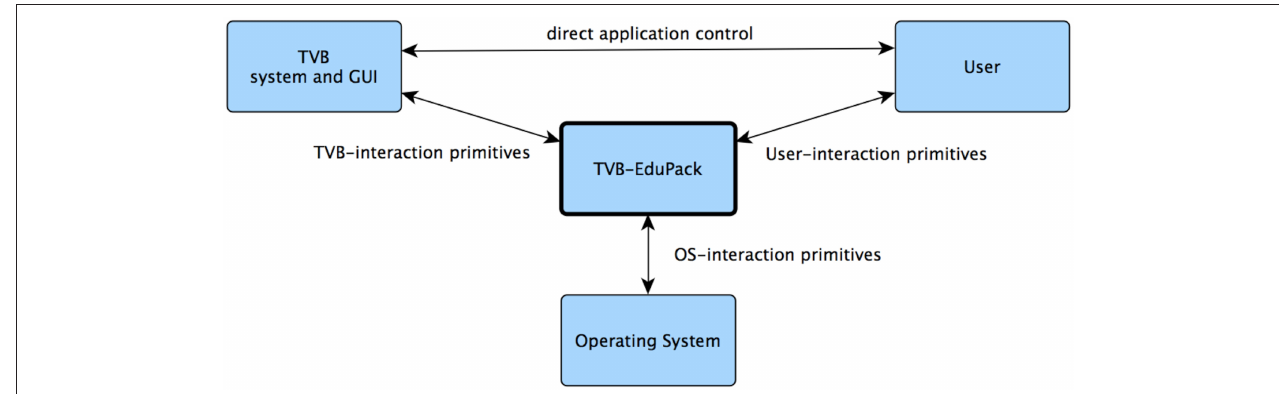
FIGURE 2 | EduPack’s two-way interaction